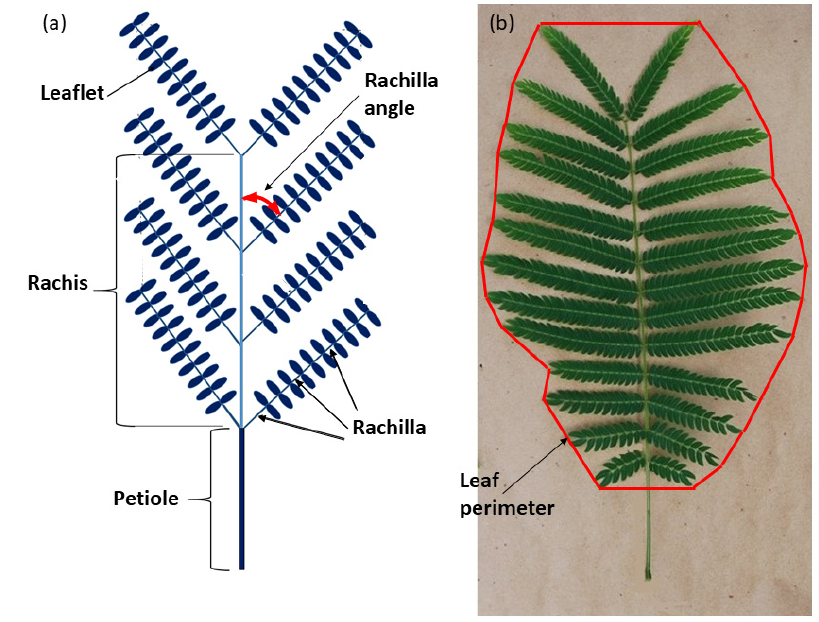
Figure 1. Representative Serianthes nelsonii bi-pinnately compound leaf. ( a ) Schematic with key structures labeled. ( b ) Actual leaf showing method of defining leaf perimeter.